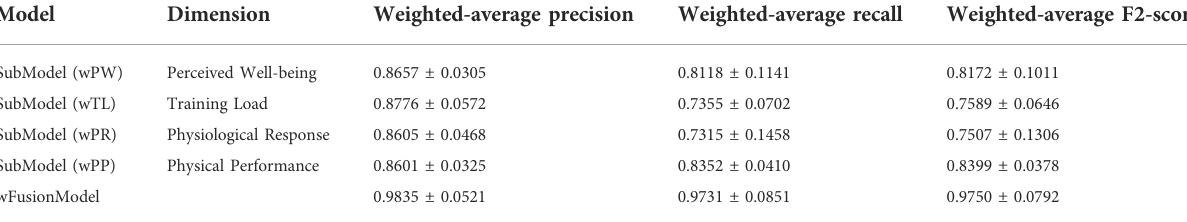
TABLE 4 Performance levels of submodels and fusion models in dataset